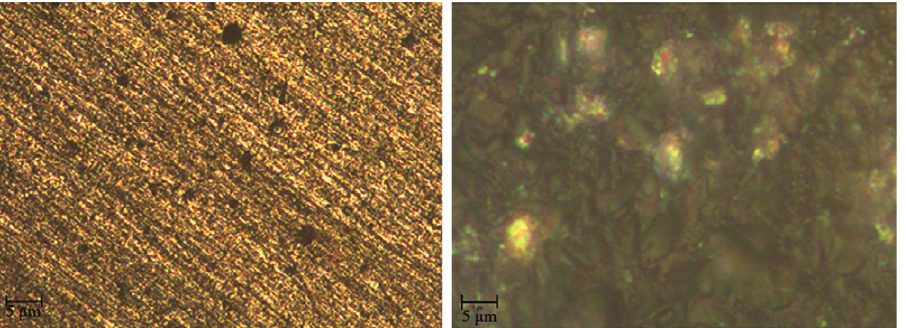
Figure 3 Light microscope photos of the indented dental porcelain surface specimen. Image magnification: × 20 (left) and × 100 (right).